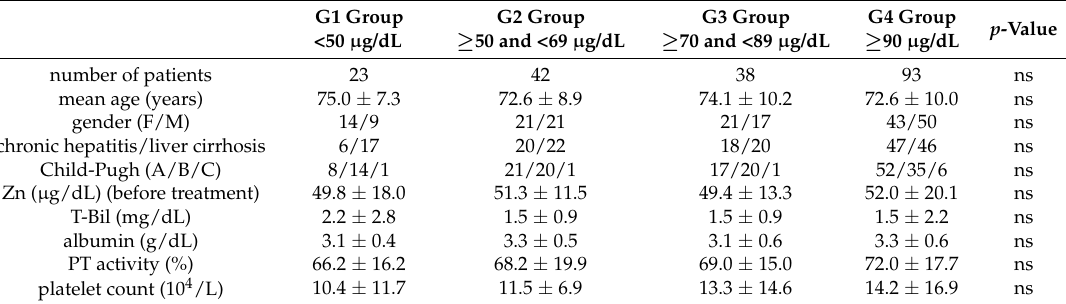
Table 2. Clinical characteristics of the 4 groups stratified by their serum zinc concentrations at 6 months after the start of the zinc